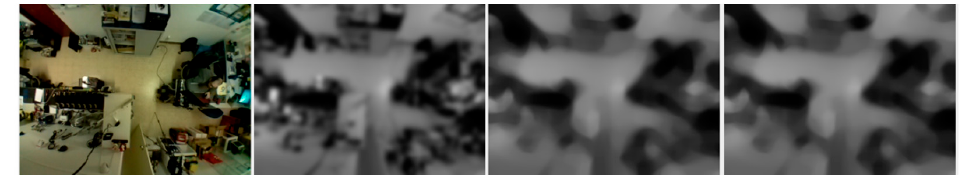
Figure 7. Some types of image blurring.